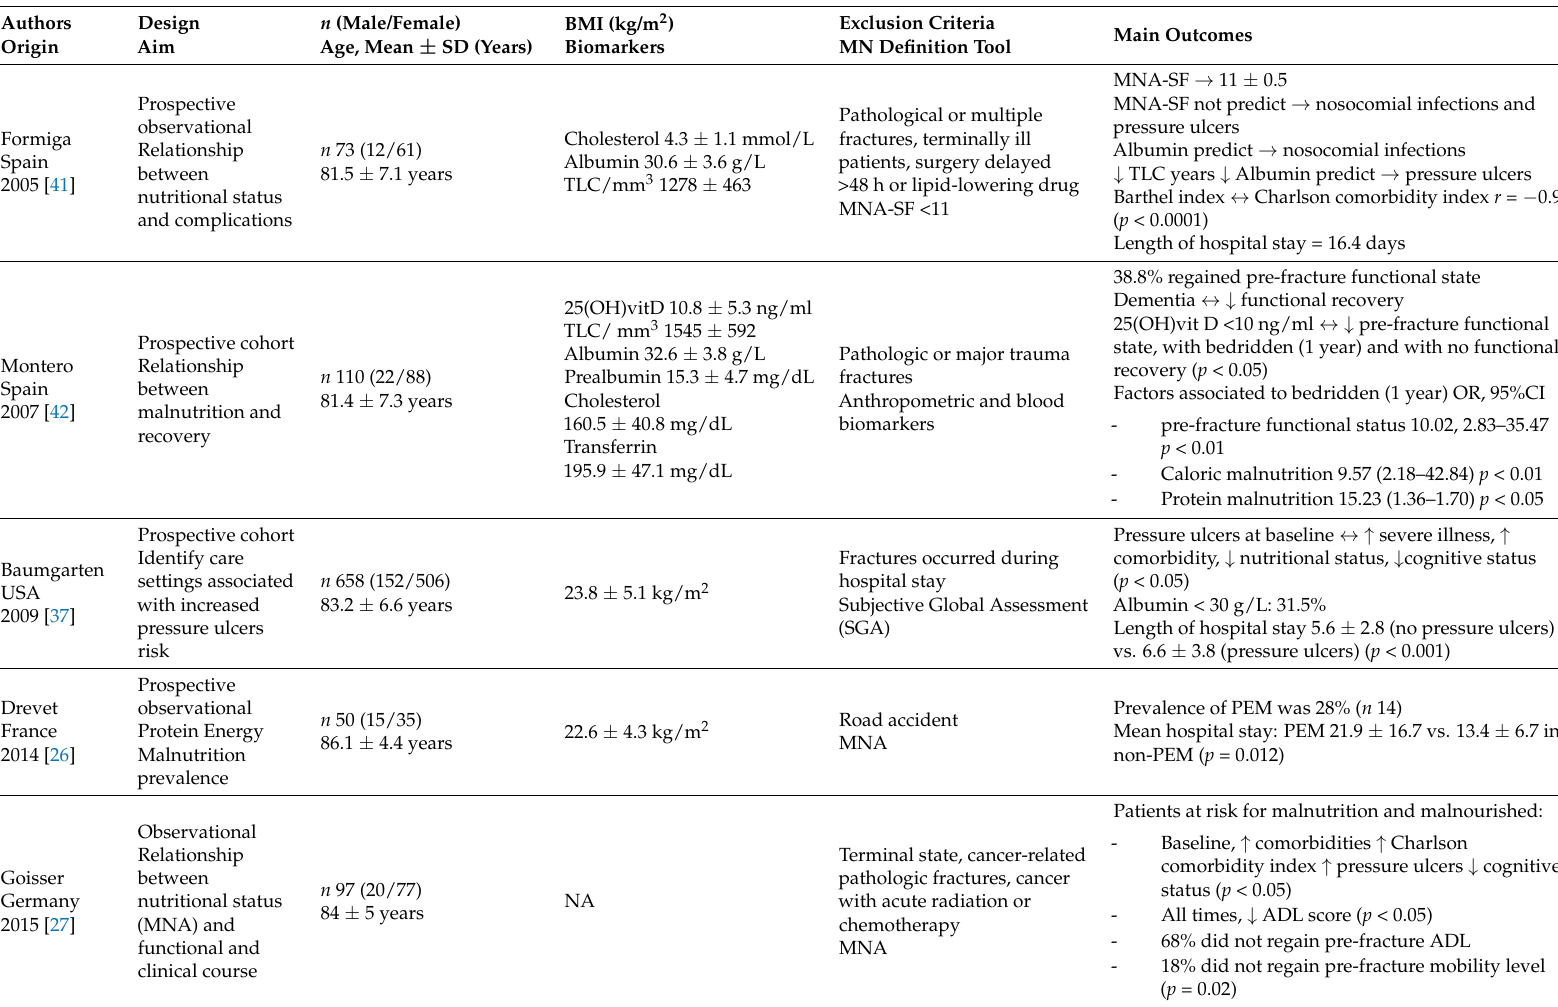
Table 3. Association of nutritional status, as revealed by nutritional biomarkers, with outcomes and post-operative